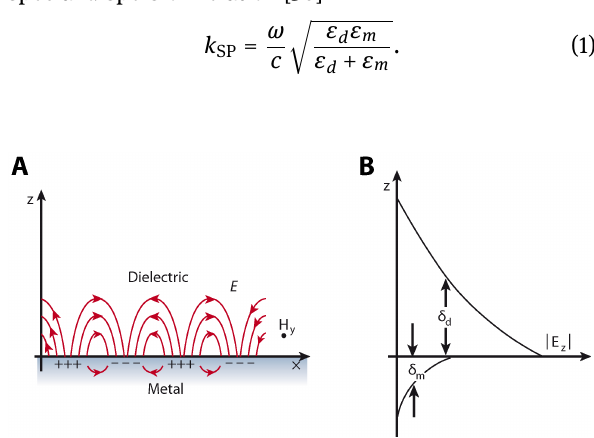
Figure 2: Schematic of a surface plasmon. a On the metal surface, charges are periodically separated, inducing fields in both the di- electric and the metal. These are evanescent and, consequently, confined in the direction perpendicular to the interface. b The decay and degree of confinement is near the diffraction limit in the dielec- tric half space, but determined by the skin depth on the metallic side (from